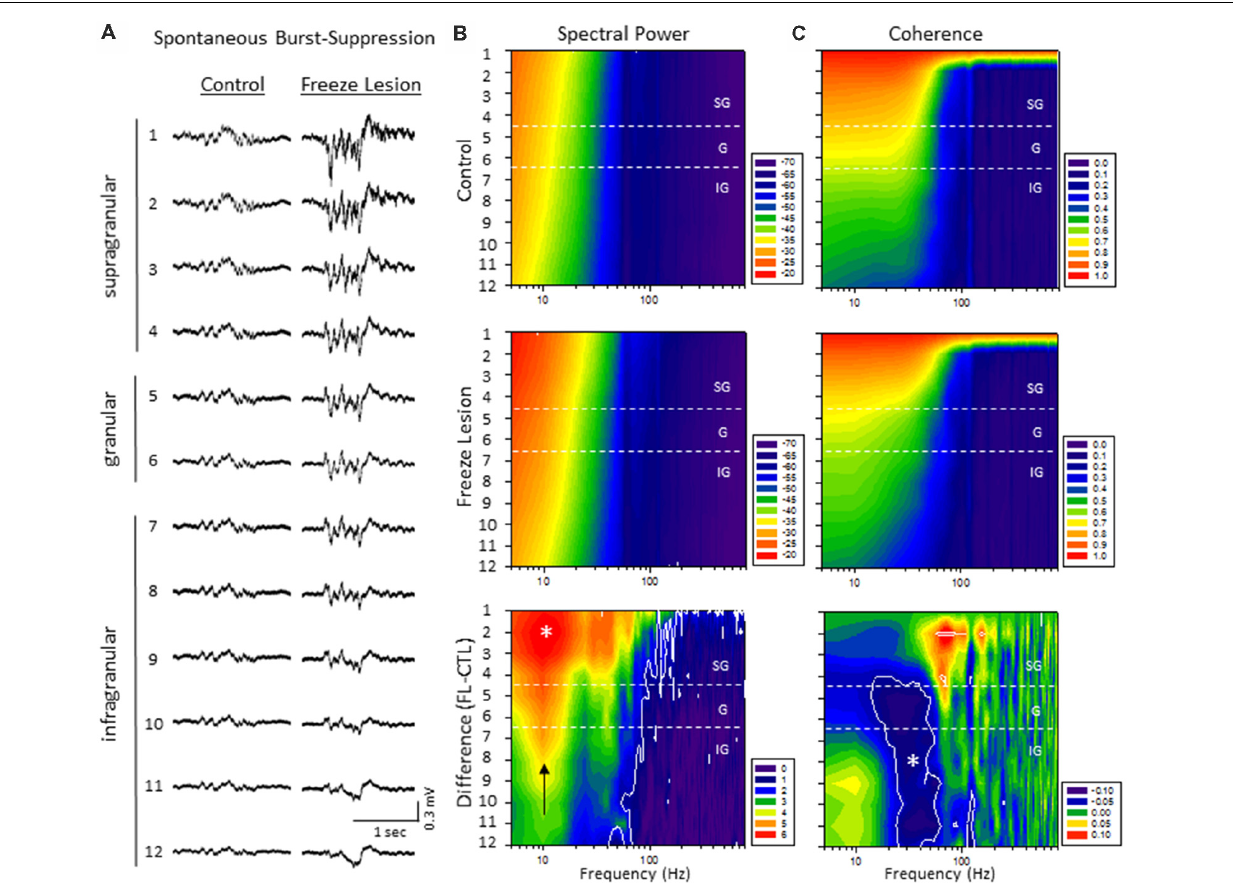
FIGURE 6 | A significant increase in spectral power and altered spectral coherence pattern were observed in the malformed cortex of freeze lesion animals as indicated from spectral analysis of linear electrode array recordings of anesthesia induced B-S. (A) Representative micro-electrode recordings of B-S events across cortical lamina from a control and freeze lesion animal under general anesthesia (2% isoflurane). (B) Average spectral power maps of control, freeze lesion, and the difference between each map. Black arrow indicates peak 10 Hz increase in PSD values from freeze lesion vs. control animals. (C) Average spectral LFP coherence maps of control, freeze lesion, and the difference between each map. (B,C) Values represent the group means from control ( n = 12) and freeze lesion ( n = 20) recordings. The topographic lines (solid white) indicate the P < 0.05 cutoff threshold and the white asterisks designate regions significantly different between groups (Holm-Sidak post hoc analysis). See “Results” section for additional statistical